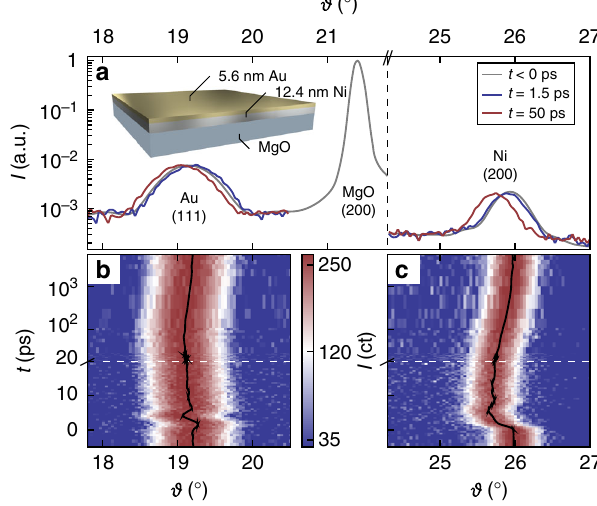
Fig. 2 Experimental data. a X-ray diffraction pattern of the sample (see inset) evidencing the crystalline orientation of the Au and Ni nanolayers. Colored lines visualize transient shifts of the Bragg peaks at selected times. Their full time evolution is shown in panels ( b ) for Au and c for Ni along with the respective peak center positions (black line). The white dashed line indicates the axis break from linear to logarithmic time scale